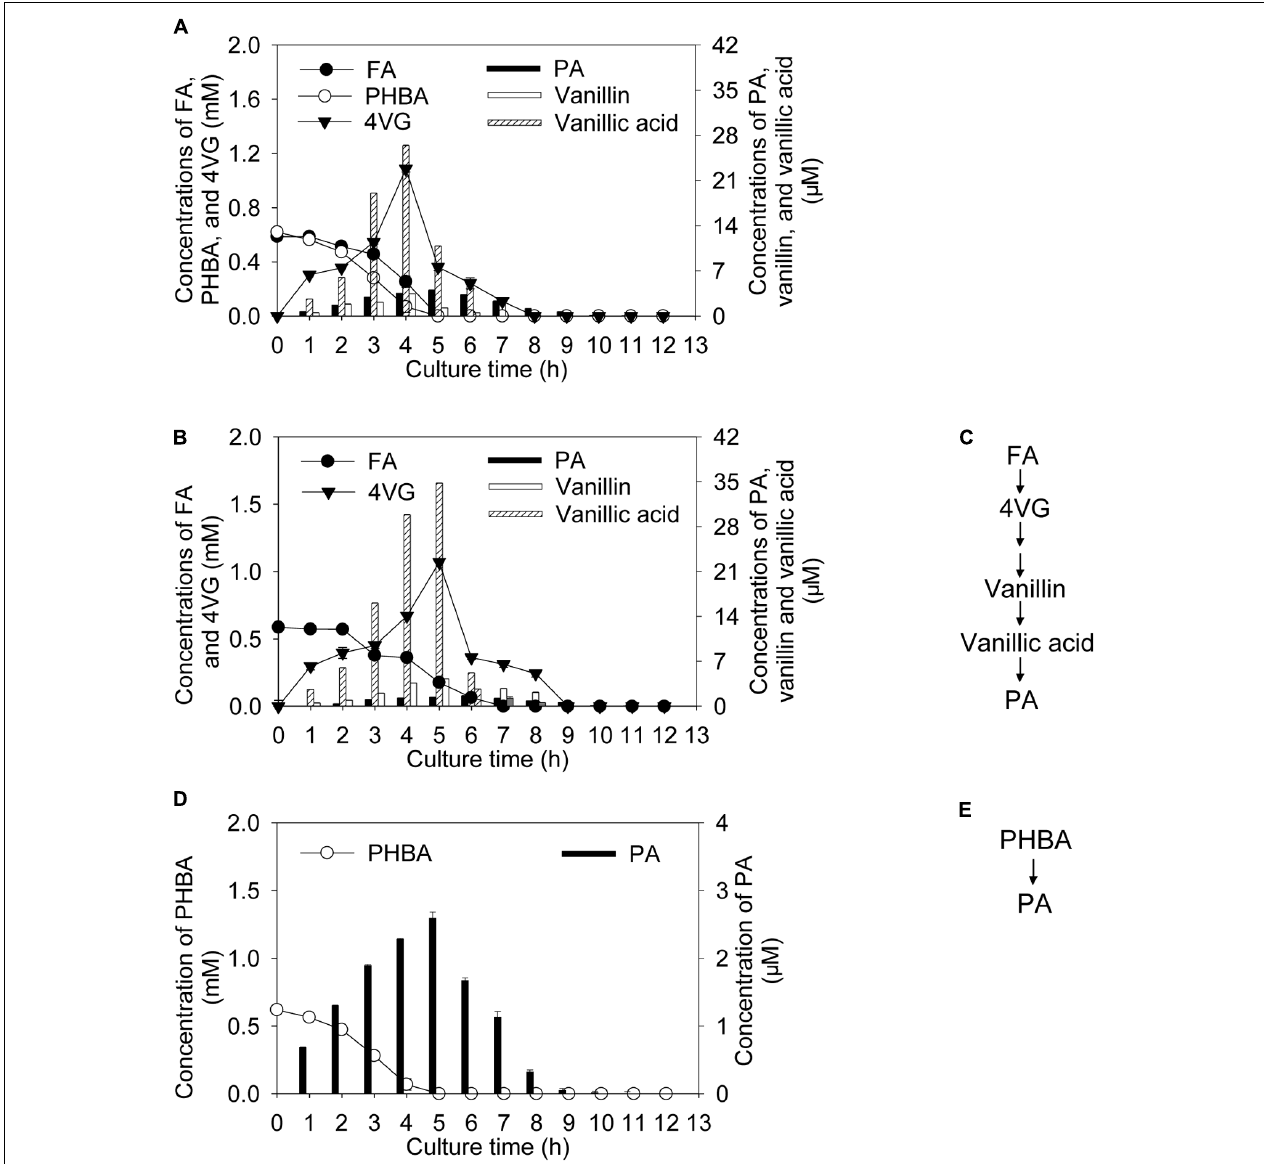
FIGURE 1 | Bioconversion products from the mixture of FA and PHBA (A) , FA (B) , and PHBA (D) , and proposed pathway of FA (C) and PHBA (E) metabolism by CSY-P13. Bars represent standard errors of three biological